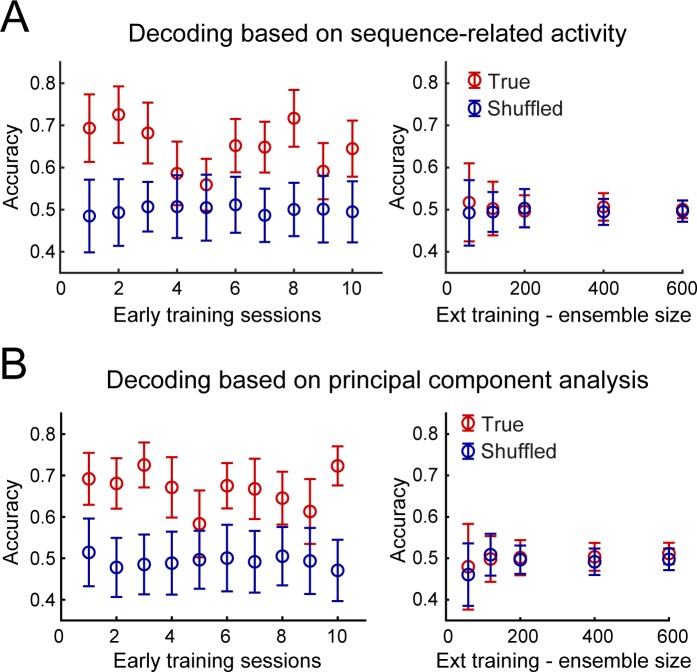
Accurate decoding of the dorsostriatal brain region identity in early training but not after extended training.(A) Mean decoding accuracy (± standard deviation) of the dorsostriatal subregion identity, DLS or DMS, of individual neurons based on their sequence-related activity (True - red) is compared with the decoding accuracy expected from chance (Shuffled - dark blue) across early training sessions (left) or during extended training, as a function of ensemble size (right). (B) Decoding based on the first three principal components following principal component analysis. Average accuracy (± standard deviation) is presented as a function of early training sessions (left) or ensemble size during extended training (right).